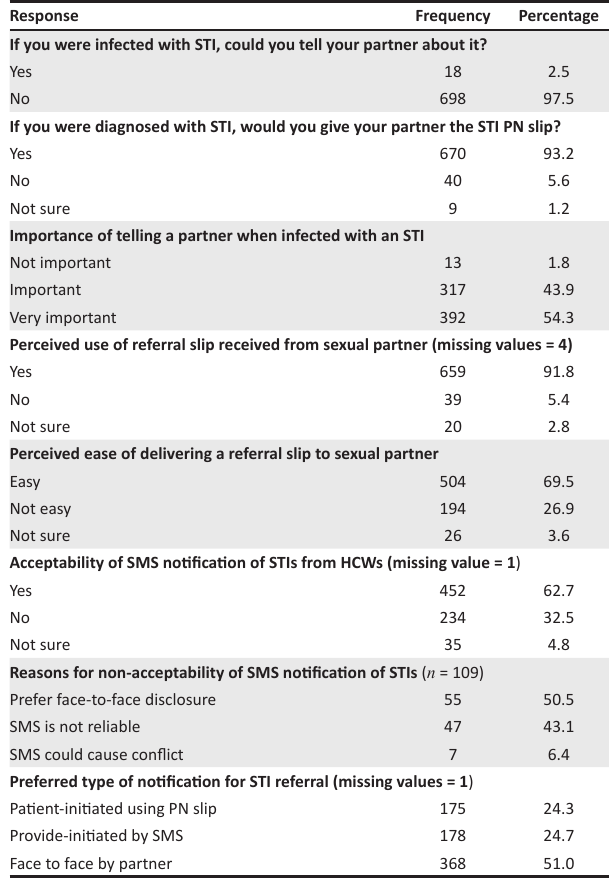
TABLE 3: Perceived use of partner notification by using referral slip and acceptability of provider-initiated partner notification by using short message service.